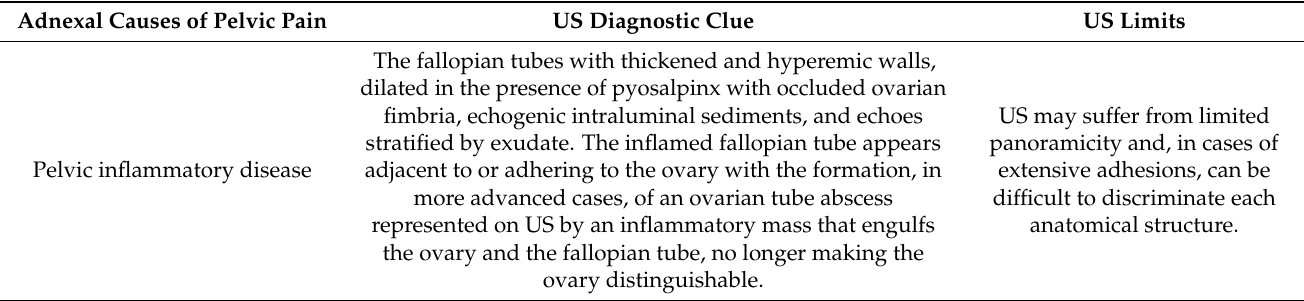
Figure 6. Tubo-ovarian complex. Axial colour-Doppler TSA–US scan of the left adnexa ( a ) shows a complex cystic mass with peripheral signal colour Doppler (( a ) arrow). Contrast-enhanced axial CT image ( b ) shows a thick enhancing left adnexa abscess wall (( b ) arrows). Rupture of tubo-ovarian abscess can result in septic shock (Table 5) [1,9]. Table 5. Inflammatory disease US diagnostic